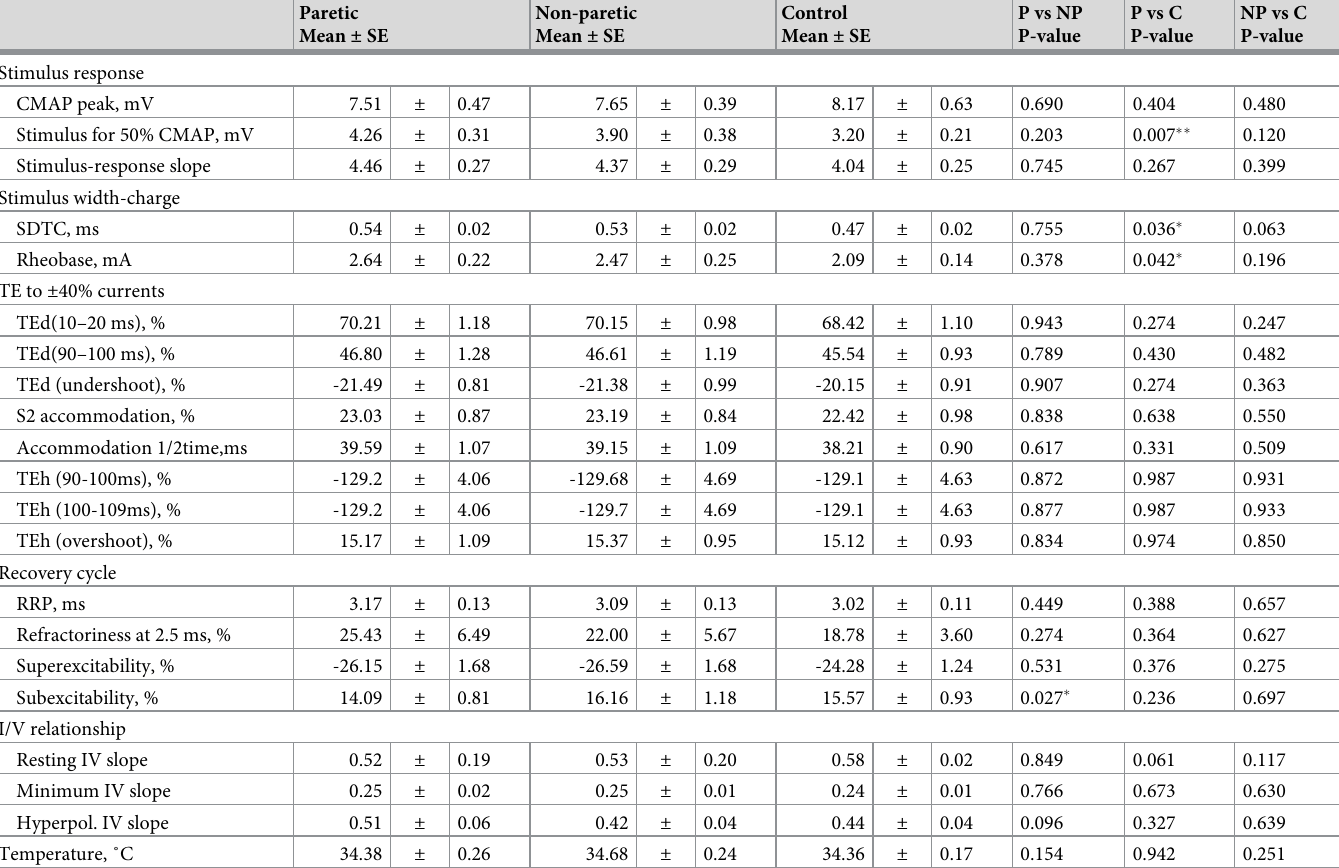
Table 2. Comparison of axonal properties by the excitability test in paretic (P), non-paretic (NP), and control (C) limbs.